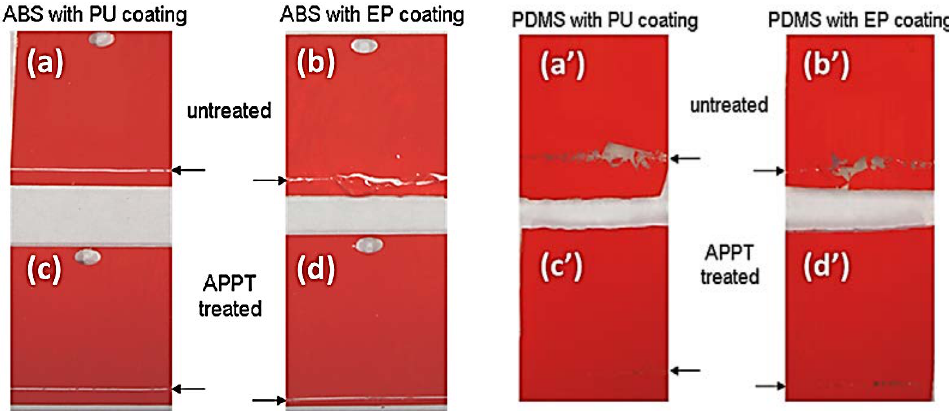
Figure 3. Scratch test on acrylonitrile-butadiene-styrene (ABS): untreated and painted with polyurethane (PU) and epoxy (EP) (( a , b ) respectively); with APPT painted with PU and EP(( c , d ) respectively). Scratch test on polydimethylsiloxane (PDMS): untreated and painted with PU and EP (( a’ , b’ ) respectively), with APPT painted with PU and EP (( c’ , d’ ) respectively).